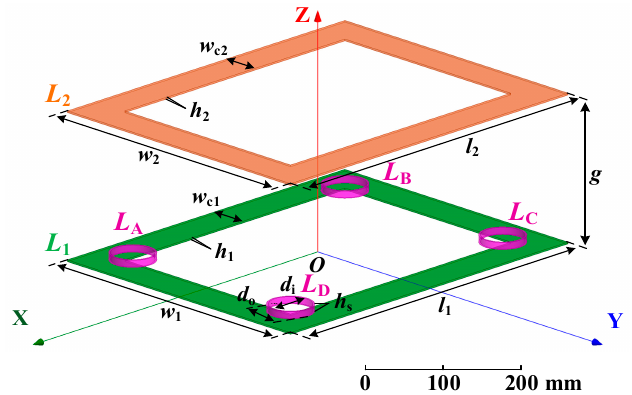
Figure 4. Coordinate system for positioning. Table 1. Coil dimensions.